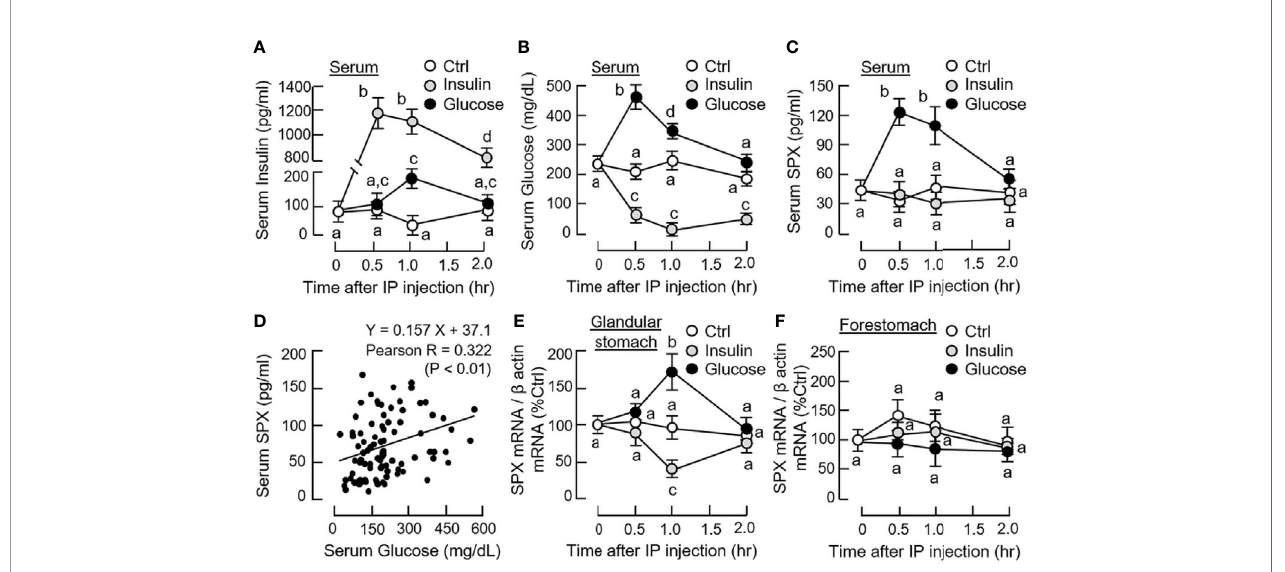
FIGURE 1 | Effects of glucose and insulin treatment on SPX level in circulation and SPX transcript expression in forestomach and glandular stomach of the mice. IP injection with glucose (2 g/kg BW) or insulin (3 IU/kg BW) was performed in the mice (with saline injection as the control and scheduled feeding time at 10 PM (without food provision) as “ time zero ” ) and blood samples and target tissues were harvested at time points as indicated. Serum levels of insulin (A) , glucose (B) and SPX (C) were measured by the respective assays. Pearson correlation analysis was also performed with the data obtained for serum SPX and glucose levels (D) . For SPX expression at the tissue level, SPX mRNA levels expressed in the glandular stomach (E) and forestomach (F) were monitored by real-time PCR for SPX transcript. (For the corresponding data on SPX gene expression in the hypothalamus, liver and omental fat, see Supplemental Figure 1 .) For the data on SPX gene expression, parallel measurement of b actin mRNA was used as the internal control and the normalized data were transformed as a percentage of the mean value in the control group at time zero (as “ %Ctrl ” ). Data presented (mean ± SEM, N = 10) were analyzed with two-way ANOVA followed by Bonferroni test and the groups denoted by different letters represent a signi fi cant difference at p <